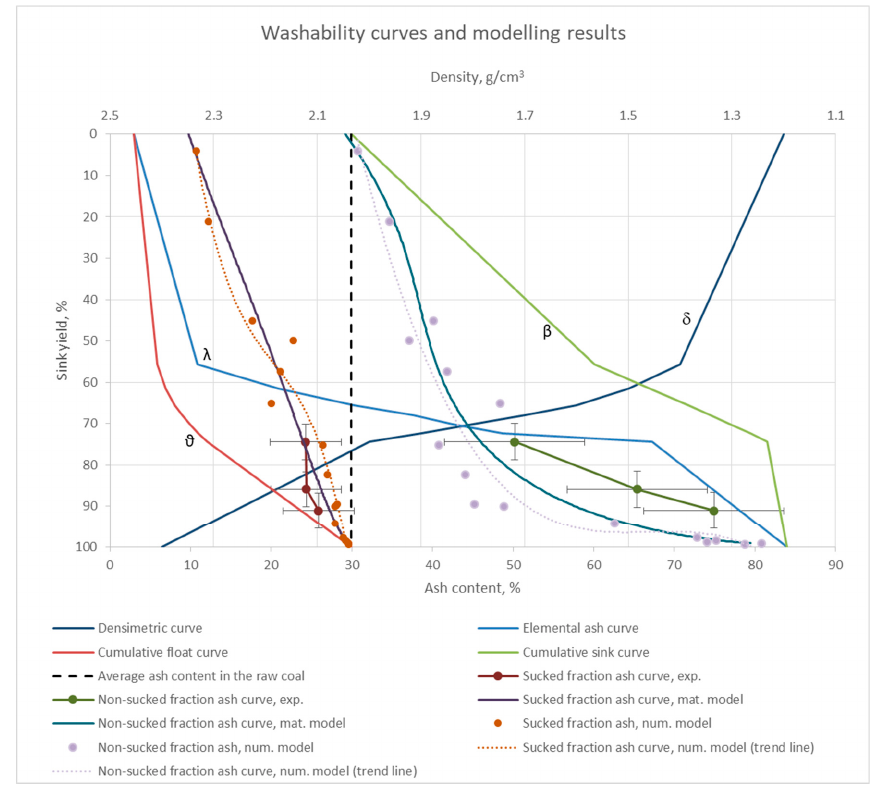
Figure A8. Summary of washability curves, enrichment curves, experimental results and modelling results—feed material no. 5 in grain size class 0–20 mm.